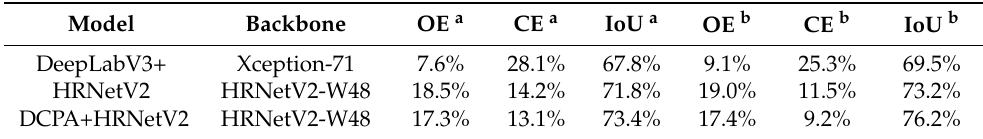
Figure 4. Active fire samples (false-colour composite and annotation) and the associated segmentation results derived from different models (green: TP; red: FN; yellow: FP). Table 3. Accuracy metrics of the active fire detection results.